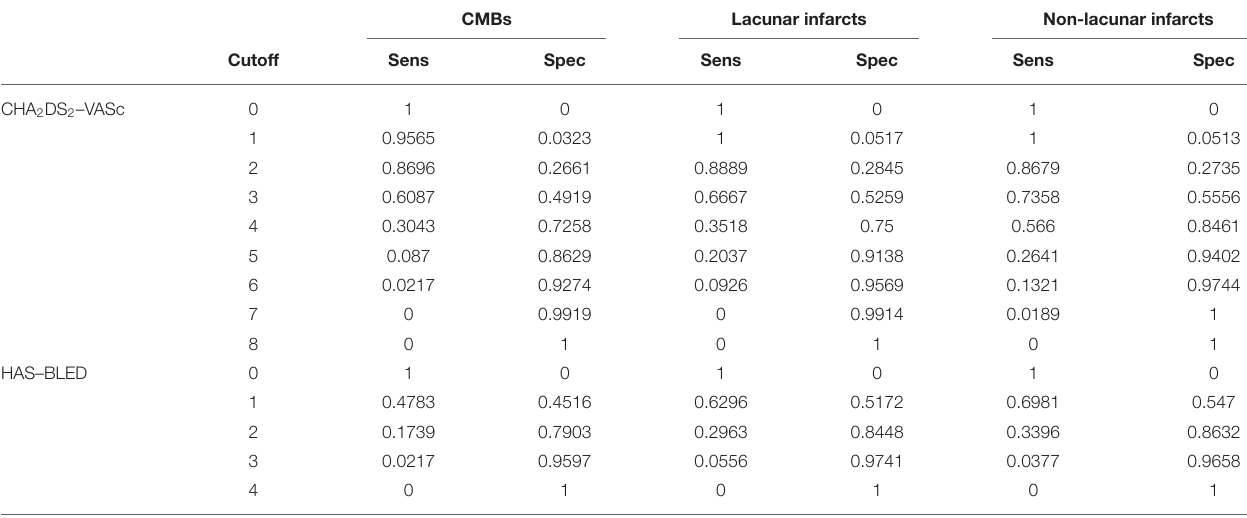
TABLE 3 | Sensitivity and specificity of CHA 2 DS 2 -VASc and HAS–BLED scales in relation to the three neuroimaging outcomes.